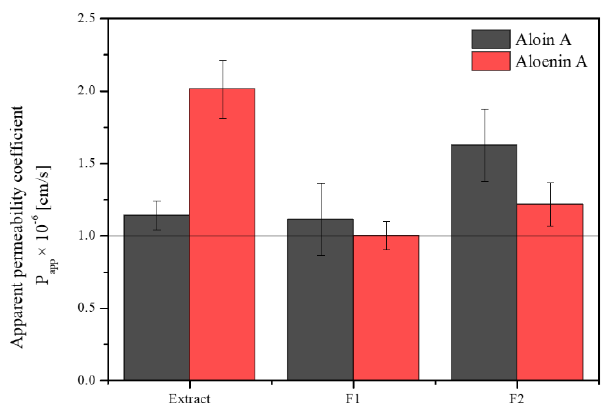
Figure 5. Apparent permeability coefficients for aloin A (black) and aloenin A (red) from formulation 1 (F1) and formulation 2 (F2) using the SKIN model. Table 6. Stability of aloin A and aloenin